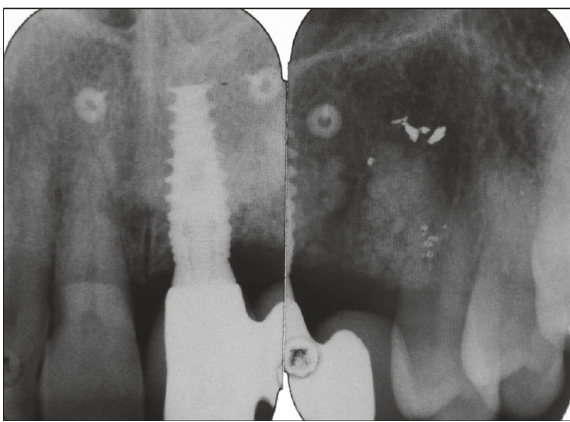
Figure2:Periapicalradiographstakenatinitialconsultation,showingarestoreddentalimplantinposition21(FDI-Notation)withnoobvious signs of peri-implantitis. That restored implant carried a two-crown distal cantilever